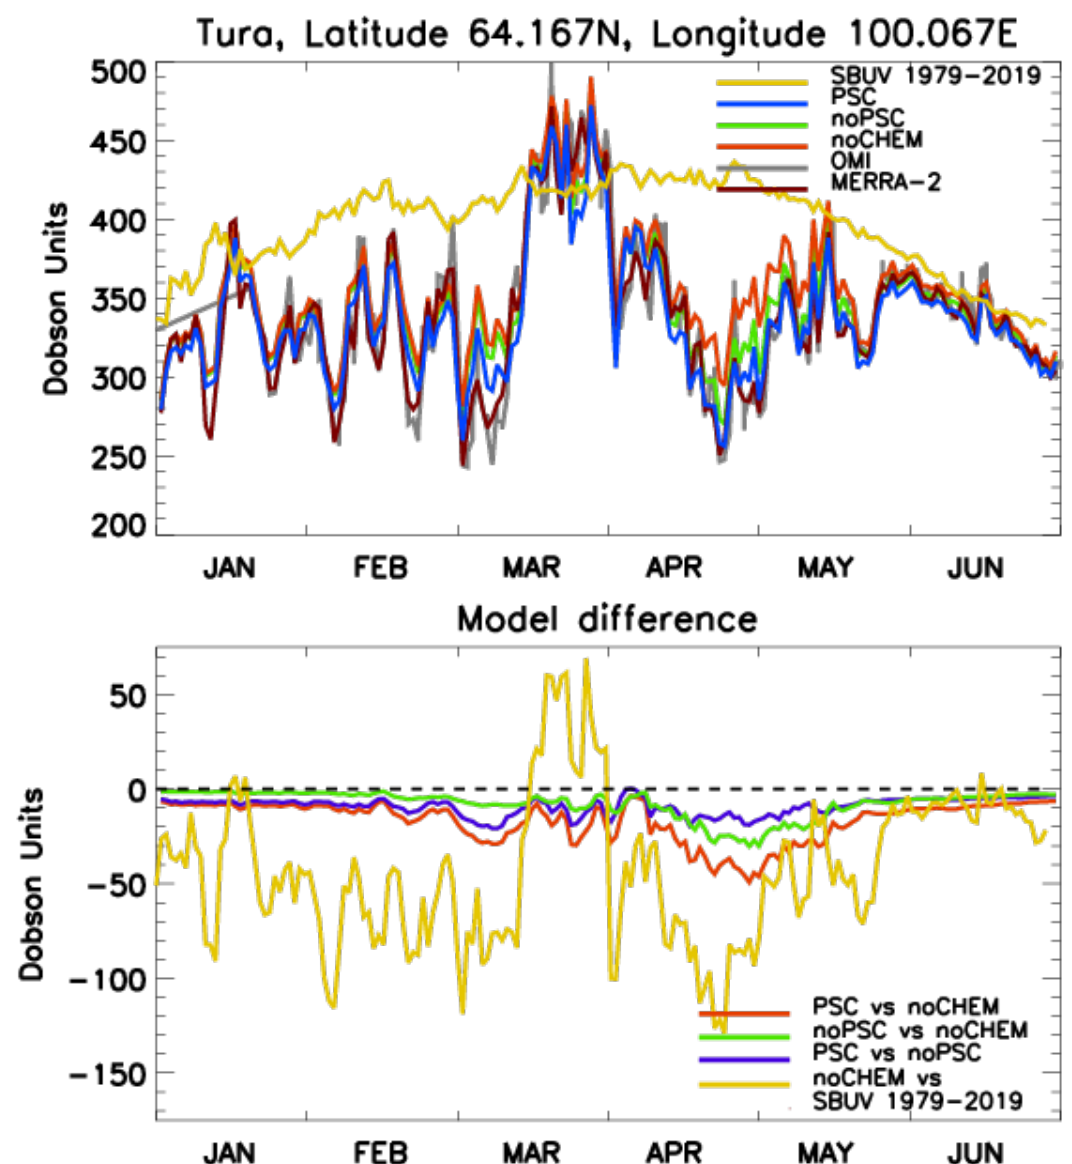
Figure 8. Column Ozone variability at Tura Station for the first half of 2020 ( top ): SBUV mean over 1979–2019 (yellow), OMI data (gray), CTM basic scenario (PSC) (blue), CTM scenario without PSC processes included (noPSCaer) (green), CTM scenario with no chemical ozone destruction included (noCHEMall) (red); and column ozone difference between CTM simulation for several scenarios ( bottom ): noCHEMall and SBUV 1979–2019 averages (yellow), PSC and noCHEMall (red), and PSC and noPSCaer (blue).